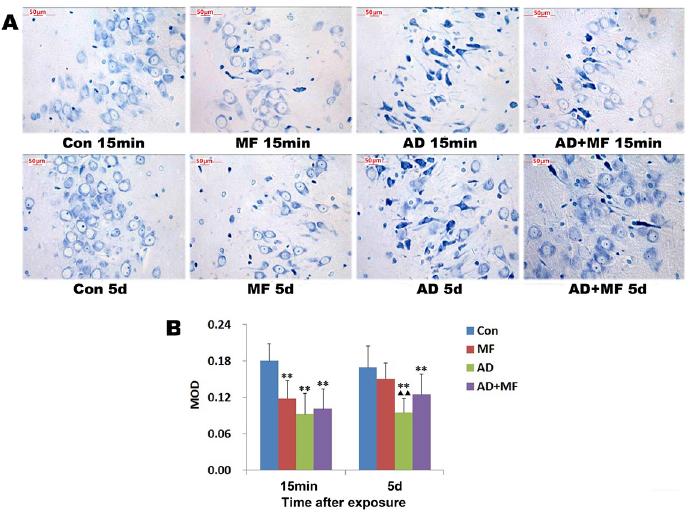
Fig 4. Nissl bodies changes in the CA3 region of rat hippocampus after exposure to 50 Hz and 400 μ T of ELF-EMF for 60 days. (A) Toluidine blue staining. (B)Image analysis results of Nissl bodies. The mean optical density (MOD) was calculated and used to judge the content change of Nissl bodies. vs Con ** P < 0.01 * P < 0.05, vs MF ▲▲ P < 0.01 ▲ P < 0.05, vs AD P < 0.01 P <